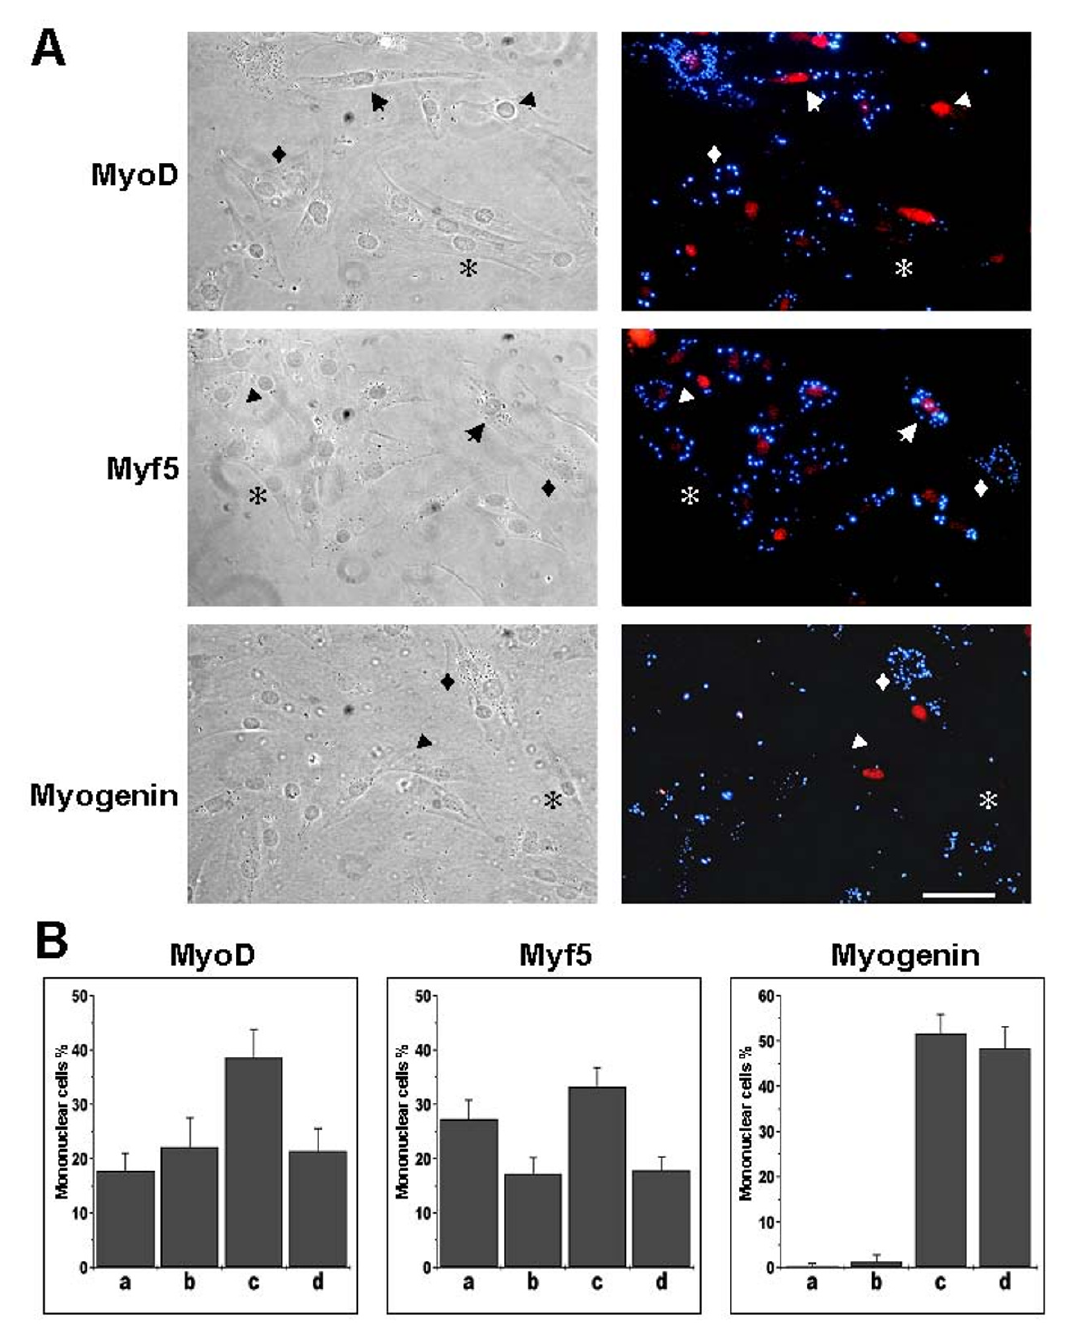
Figure 3 Alkaline phosphatase positive mononuclear cells express myogenic regulatory factors . Mononuclear cells were isolated from C2C12 cell cultures after 6 days of differentiation in presence of 30 mM sodium chlorate. Permeabilized cells were fixed and stained for alkaline phosphatase activity using ELF-97 detection kit and for MRFs using polyclonal anti-mouse MyoD, anti-human Myf5 or anti-rat myogenin antibodies. TRITC-conjugated anti-rabbit IgG was used as secondary antibody. Symbols represent: arrow, MRF+/ALP+; arrowhead, MRF+/ALP-; diamond, MRF-/ALP+; asterisk, MRF-/ALP-. Bar = 50 μ m. B . Quantification of single or double labeled cells was performed in 10 independent fields. a, MRF+/ALP+; b, MRF+/ALP-; c, MRF- /ALP+; MRF-/ALP-. (Mean ± S.D. of two independent